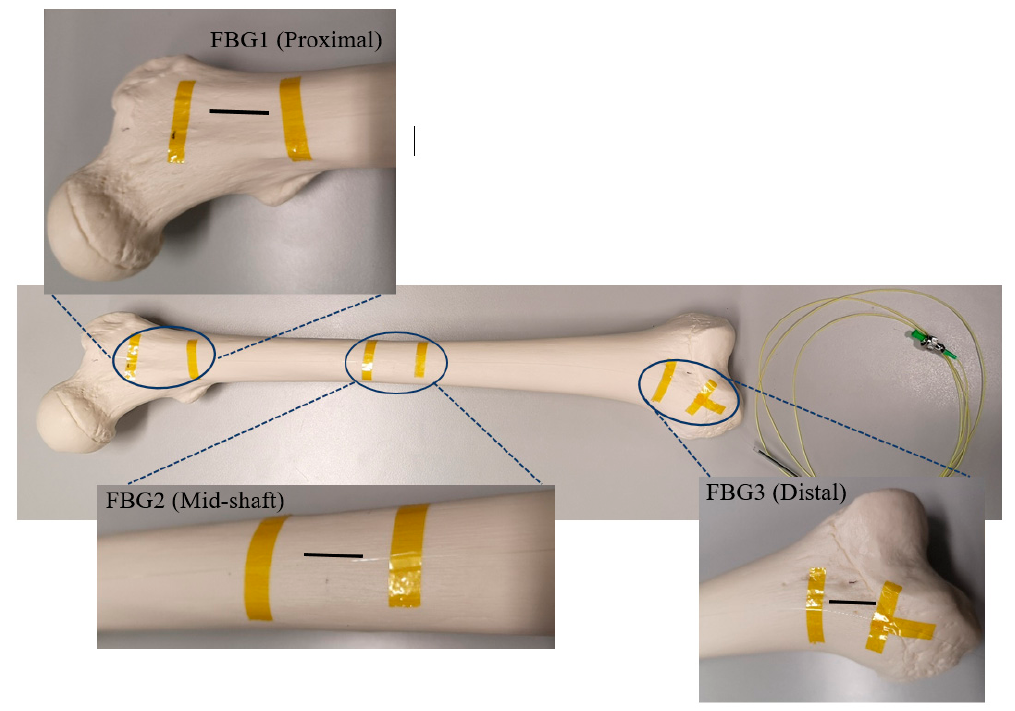
Figure 1. Intact femur with the secured Fibre Bragg Grating (FBG) array, including three